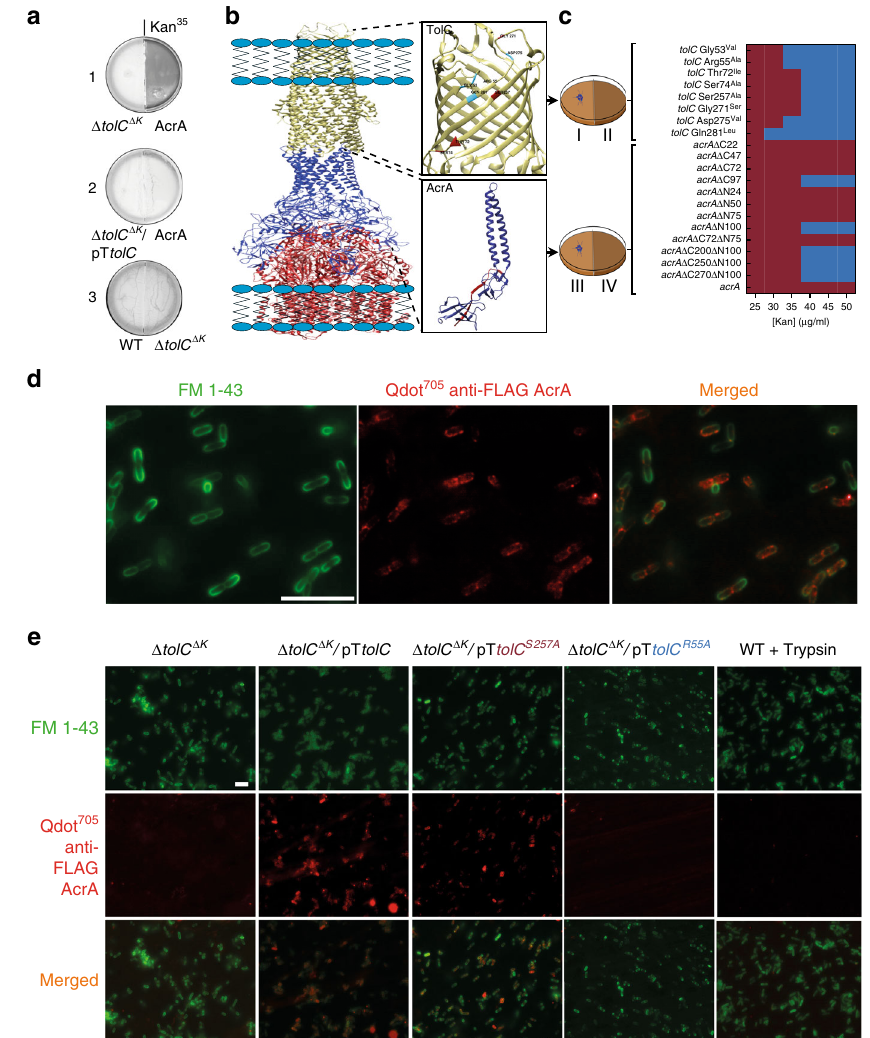
Fig. 4 AcrA binds TolC externally as a necrosignal. a The AcrA response requires TolC. Genotypes of E. coli strains inoculated on the left or proteins/pre- killed cells applied on the right are indicated below the plates. The tolC deletion reduces SR to Kan 25 , therefore Kan 35 was used in these plates. Strain Δ tolC Δ K has its Kan R marker removed ( Δ K; see Supplementary Table 1 and “ Methods ” ). b A model of the AcrAB-TolC ef fl ux pump (PDB ID: 5NG5) visualized and drawn (not to scale) using Chimera 93 , with TolC and AcrA components enlarged. The enlarged view for TolC shows the residues mutated in this study, with maroon and blue indicating SR + and SR − outcomes, and similar colors in AcrA indicating the importance of the HTH region for SR + activity. c Summary of data delineating residues in TolC, and regions in AcrA, important for SR. For TolC analysis, tolC mutants expressed from pTrC99a plasmids in a Δ tolC Δ K strain were inoculated on the left (I), with puri fi ed AcrA on the right (II). For AcrA, WT cells were inoculated on the left (III), and pre-killed cells expressing the indicated C- and N-terminal truncated versions of AcrA from pTrc plasmids in a Δ acrA Δ K strain (Kan marker removed) were applied on right (IV). SR response color scheme as in Fig. 1e. See Supplementary Fig. 6 for primary data. d Imaging of AcrA binding to the outer membrane of WT swarm cells. QDot 705 -labeled anti-FLAG antibody was used to label AcrA-FLAG, and FM-143 dye to label the outer membrane (see “ Methods ” ). The entire fi eld of view is shown in Supplementary Fig. 7a. Scale bar, 10 μ m. See Supplementary Fig. 7d for binding of Qdot alone (control). e AcrA-TolC co- localization in representative SR + and SR − TolC mutants identi fi ed in ( c ) and treated as in ( d ). See Supplementary Fig. 7b for bright fi eld images. Scale bar, 10 μ m. The last panel is a control to show that AcrA is not internalized. Here, WT swarm cells were pre-incubated with AcrA and subsequently treated with trypsin followed by addition of the Qdot (see “ Methods ” ). See Supplementary Fig. 7c for western blot analysis of these samples. Source data are provided as a Source Data fi